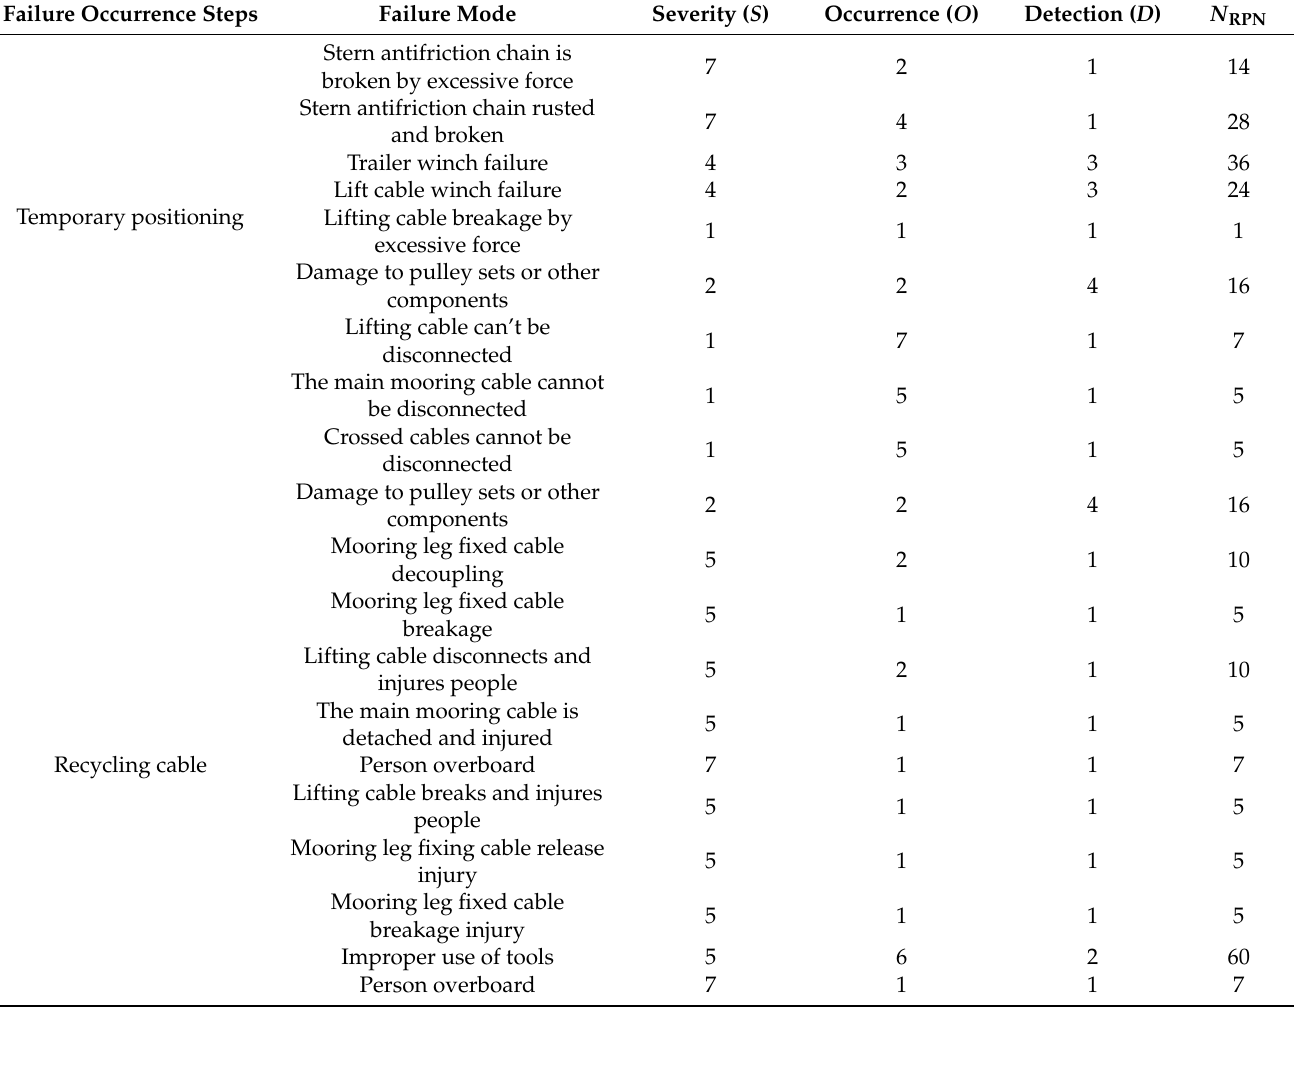
Table 5. Equipment recovery stage.